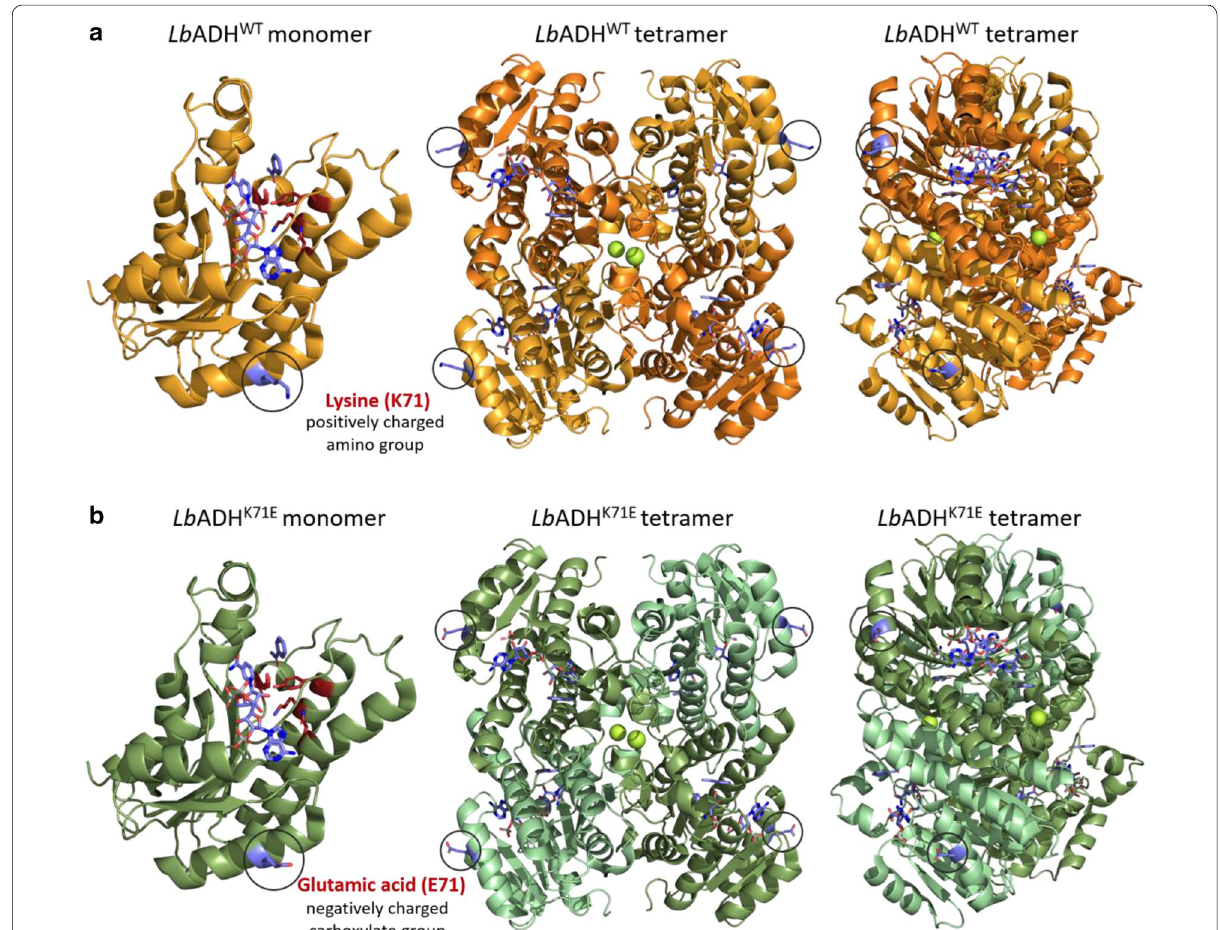
Fig. 4 Crystal structure of the Lb ADH WT monomer and the homotetramer in complex with the substrate acetophenone and the cofactor NADPH (Schlieben et al. 2005) ( a ) and modelled structure of Lb ADH K71E ( b ). In the tetrameric structure, the Mg 2 + ions needed for structure stabilization are shown as light green spheres. The amino acids at position 71 are shown as sticks and marked with a black circle. The residues Asn113, Ser142, Tyr155, Lys159 involved in the catalytic mechanism are shown in red as sticks in the monomer. The images were generated with the software PyMOL 2.2.0 (PDB code